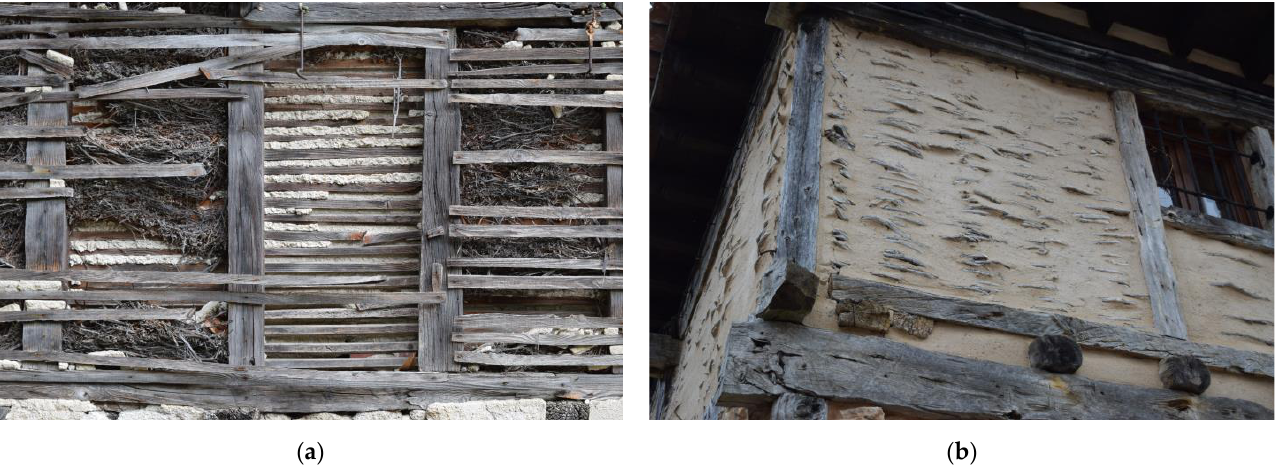
Figure 2. Examples of half-timber walls with lightweight screens: ( a ) rigid screens of lath-and-daub in As Ermidas (Ourense); ( b ) flexible screen of wattle-and-daub in Calatañazor (Soria).